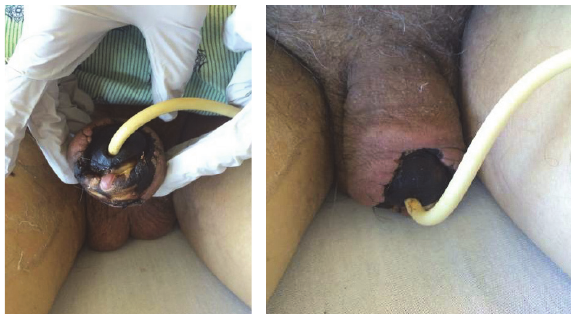
Figure 1: Gangrene of glans